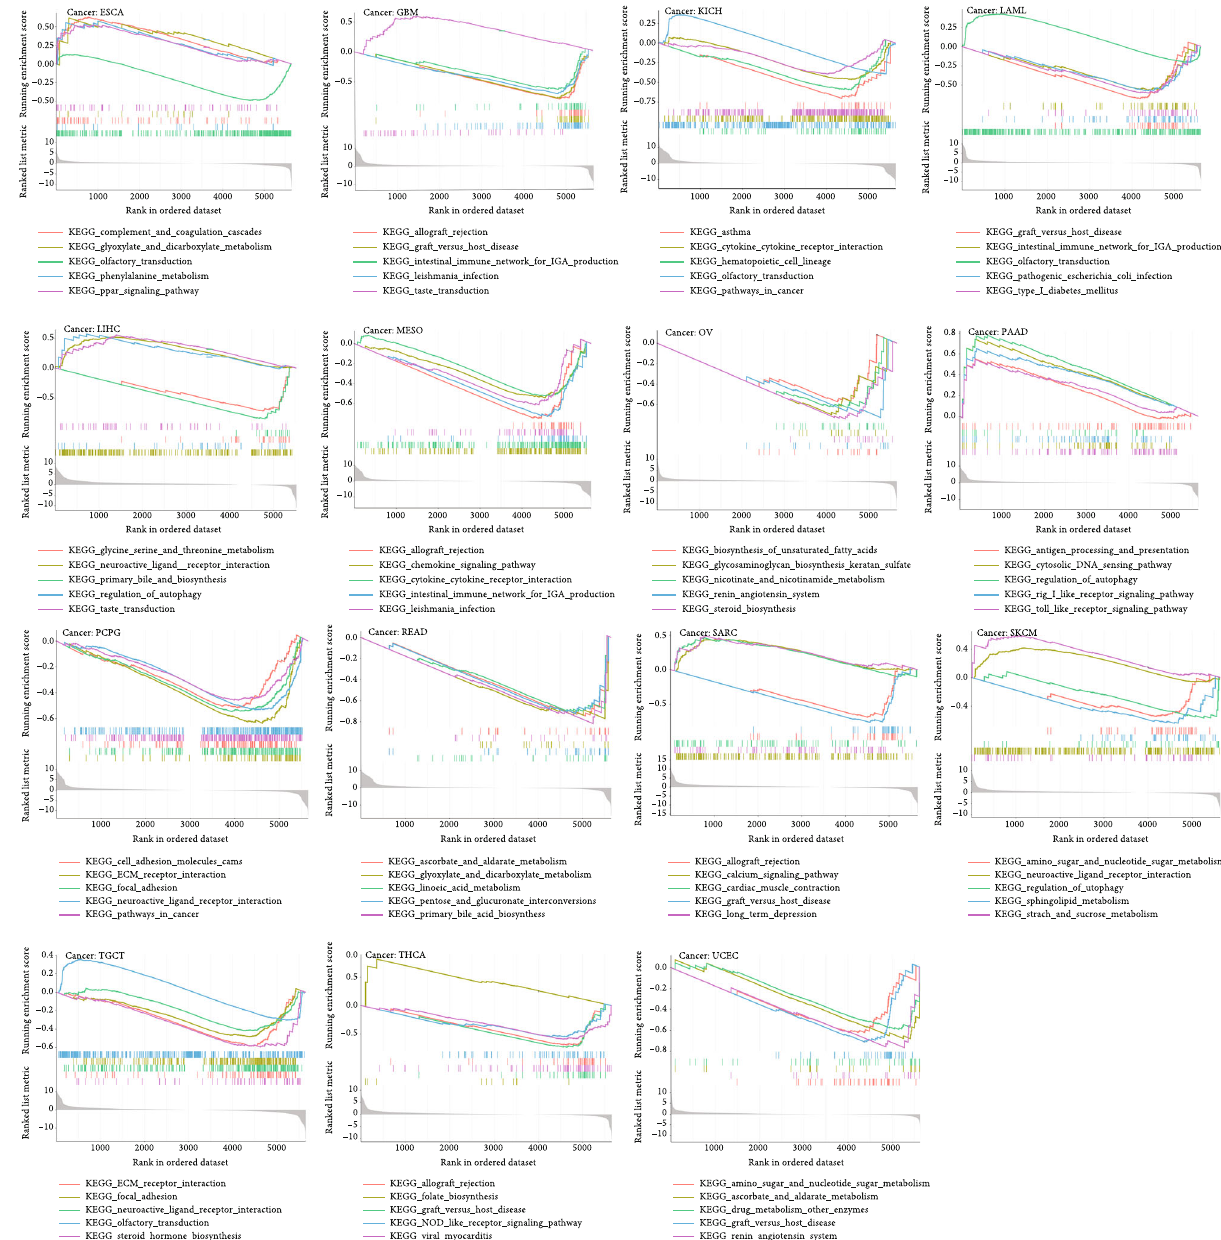
Figure 9: KEGG analysis of high and low expression of BACE1-AS in pan-cancer. Each of the di ff erent colored lines represents a speci fi c gene set. The upregulated genes were showed at the left side near the origin, while the downregulated gene set was at the right side. Only P value < 0.05 was considered signi fi